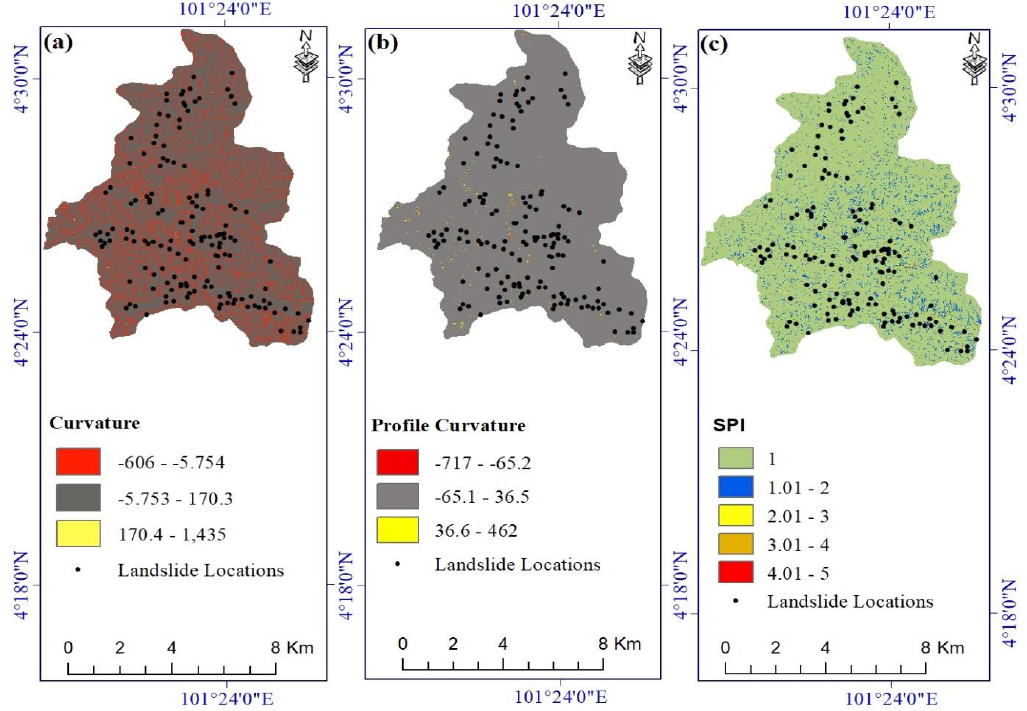
Figure 3. Landslide conditioning factors: ( a ) curvature, ( b ) profile curvature, and ( c ) SPI.